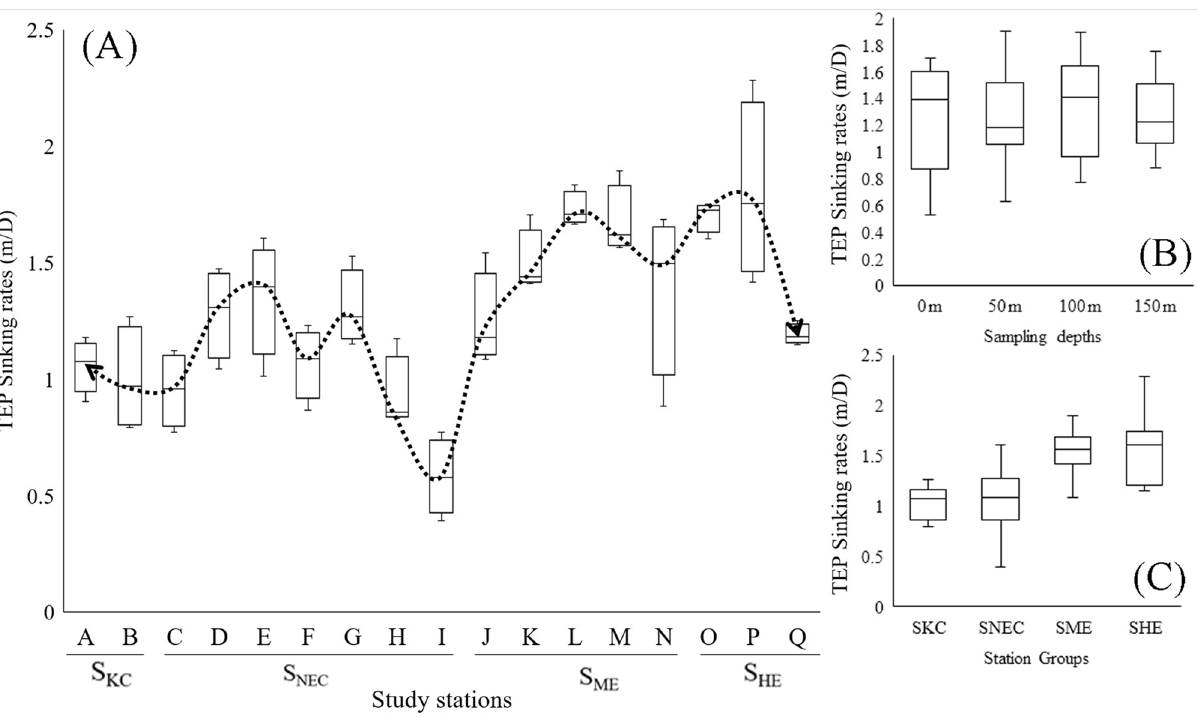
Figure 6. Average variation in sTEP through all sampling stations with line fluctuations ( A ) at each water depth ( B ) and in each section ( C ) in the